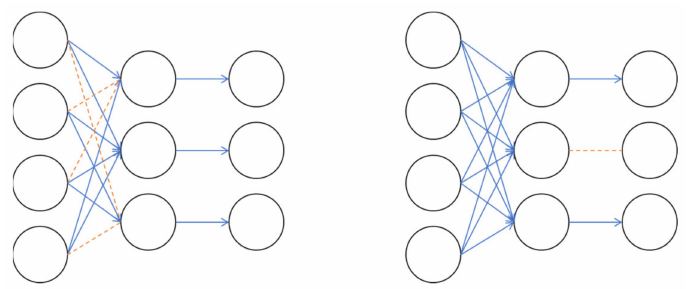
Figure 8. Drop Connect and Drop